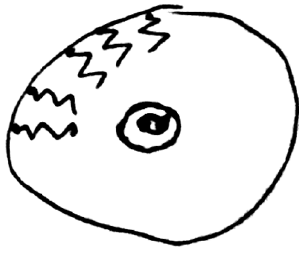
FIG. 3. Student ’ sketch of inner processes within a star.